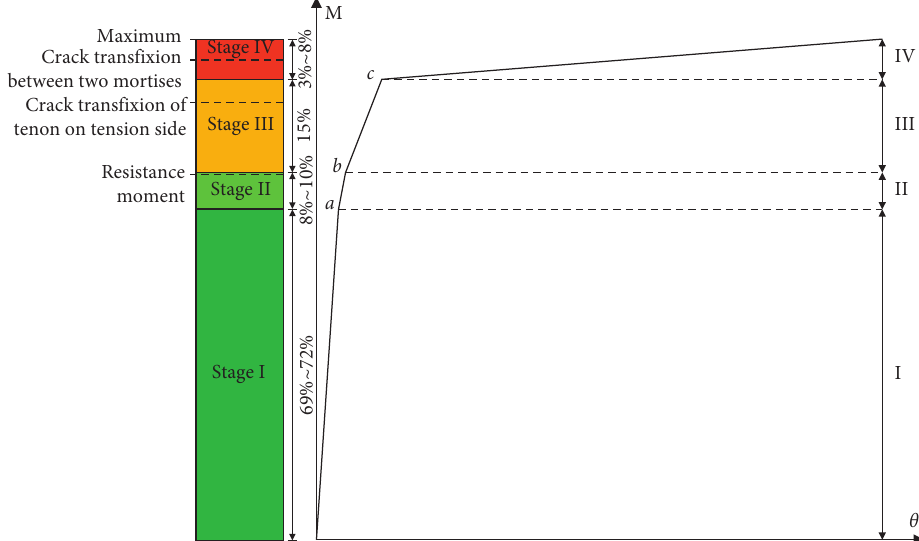
Figure 13: Bearing stage of bearing characteristic curve for grouted mortise-tenon